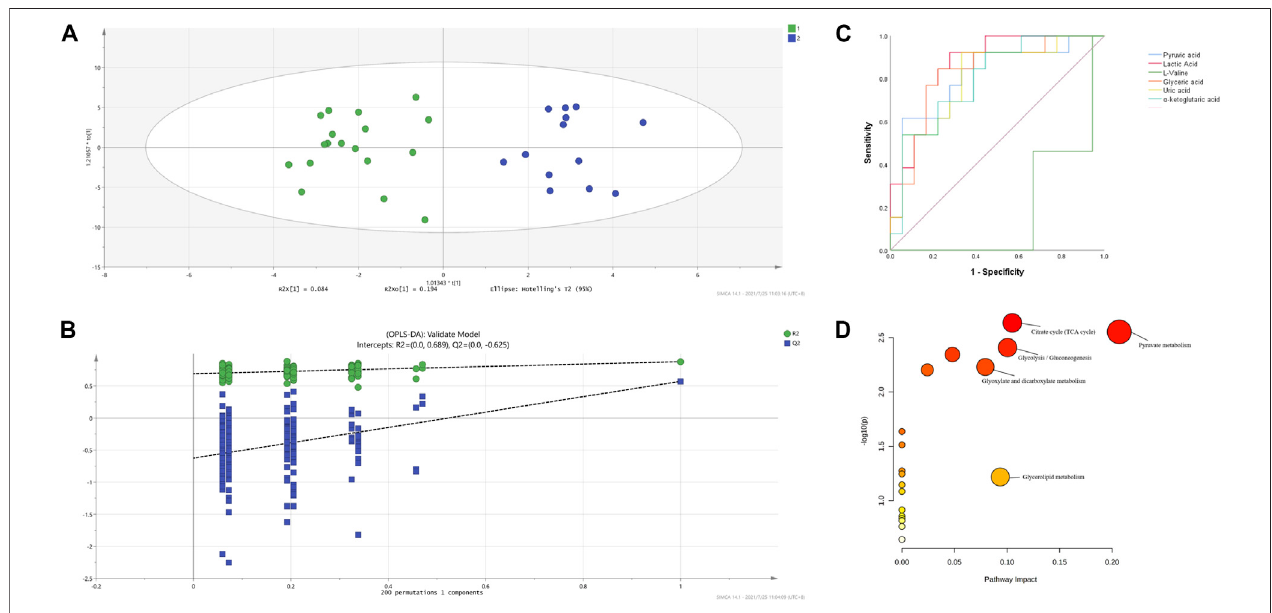
( Figure 3D ): citrate cycle, pyruvate metabolism, glycolysis/ gluconeogenesis, glyoxylate and dicarboxylate metabolism, glycerolipid metabolism (impact value > 0.05 and -log10(p) > 1) ( Table 3 ).